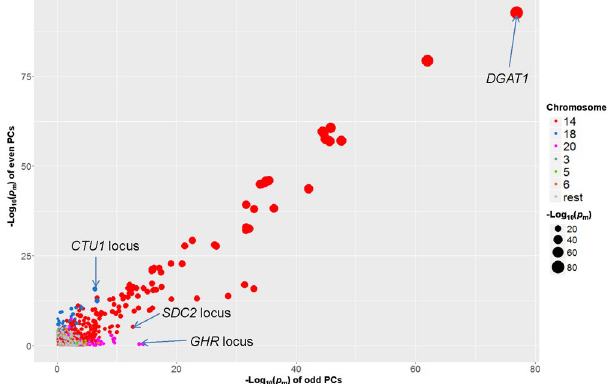
Figure 4. Relationship of multi-trait meta-analysis significance ( p m ) between odd (e.g., 1, 3, 5 … ) and even (2, 4, 6 … ) principle components (PCs). Some known loci affecting milk traits were